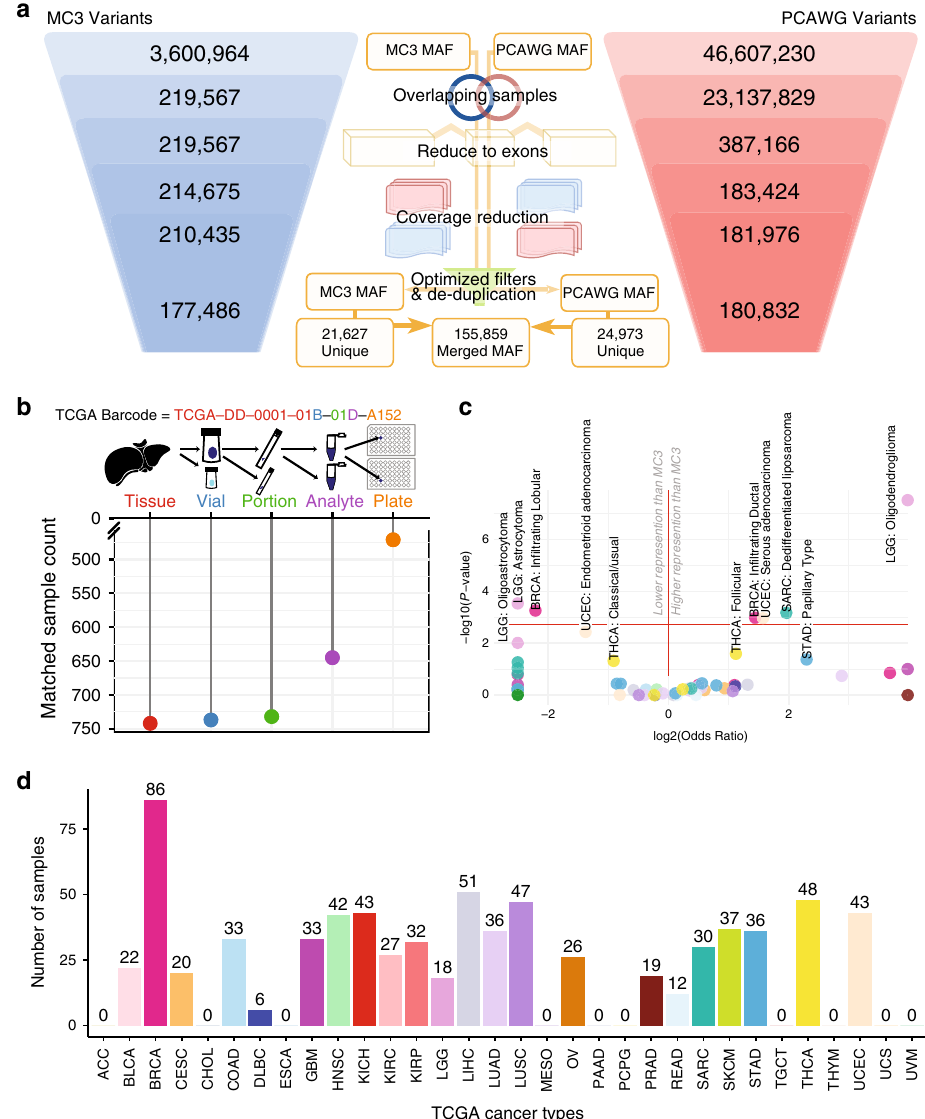
Fig. 1 Work fl ow and sample inclusion statistics. a A work fl ow diagram illustrates the number of mutations present during each step (gradient) of the fi ltering processes for MC3 (left, blue) and PCAWG (right, red). A brief description of each step of the intersection process is shown in between. b TCGA barcodes and aliquot IDs were used to match somatic sequencing. The exact match of these IDs is shown for various collection aliquots from tissue to plate. c A volcano plot highlights cancer subtype discrepancy between each PCAWG and MC3 with − log10( p -value) on the y -axis and log2(odds ratio) on the x -axis (Fisher ’ s exact test). The horizontal red bar indicates a signi fi cant threshold after multiple testing correction. Positive values indicate an over- representation of a cancer subtype in PCAWG, while negative values indicate an under-representation of a cancer subtype in PCAWG compared to MC3- separated by a vertical red bar. d Sample counts for each cancer type are shown in a bar chart. The colors coordinate with panel c